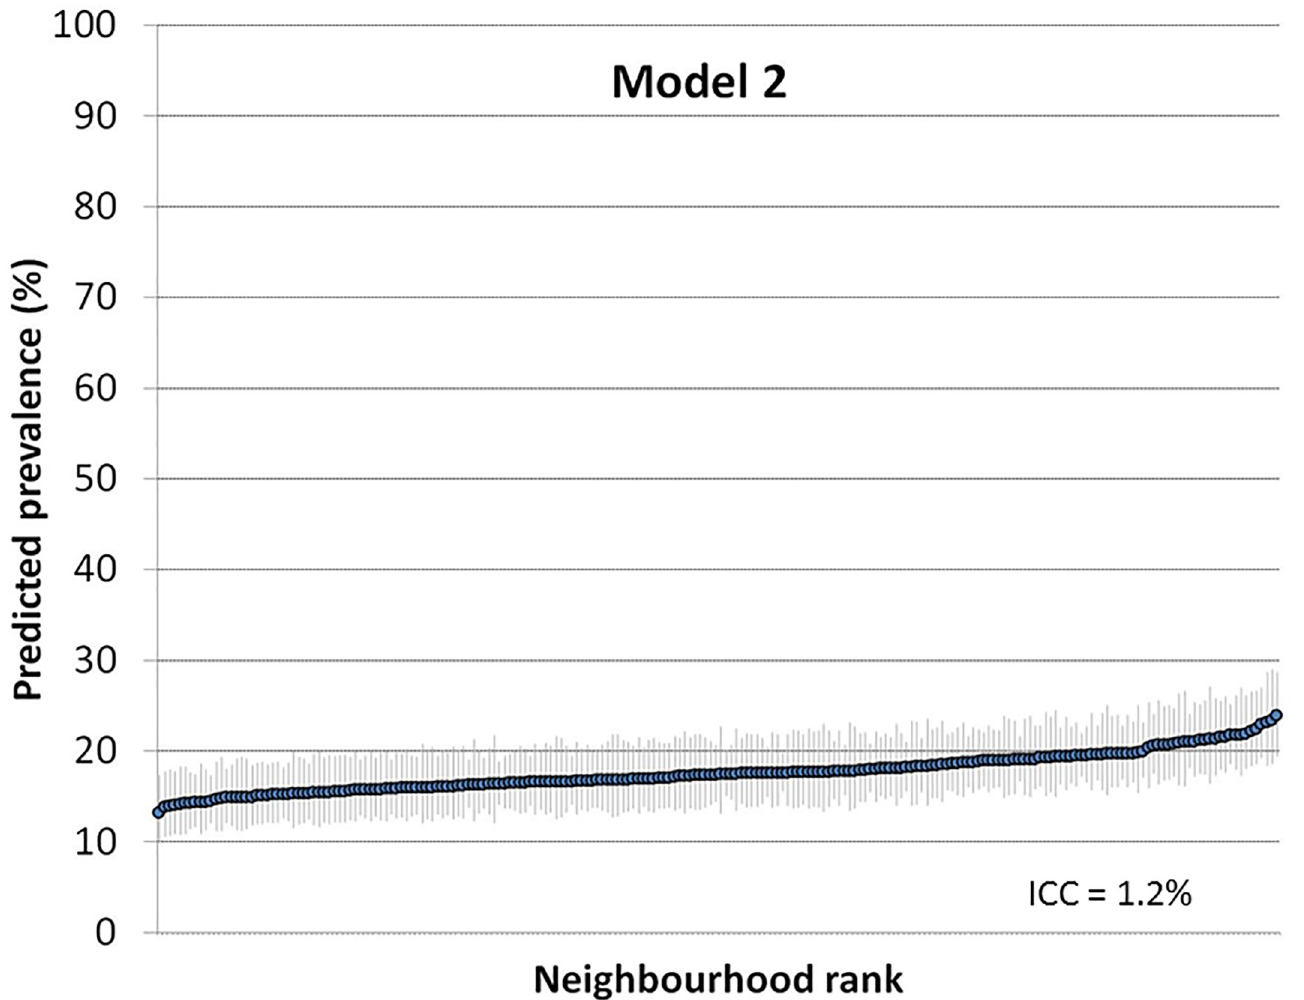
Fig 2. Predicted prevalence of psychotropic drug use in each neighborhood with 95% confidence intervals versus ranking. Predictions are for the reference individual in model 2, i.e.,female age 35 – 39, high